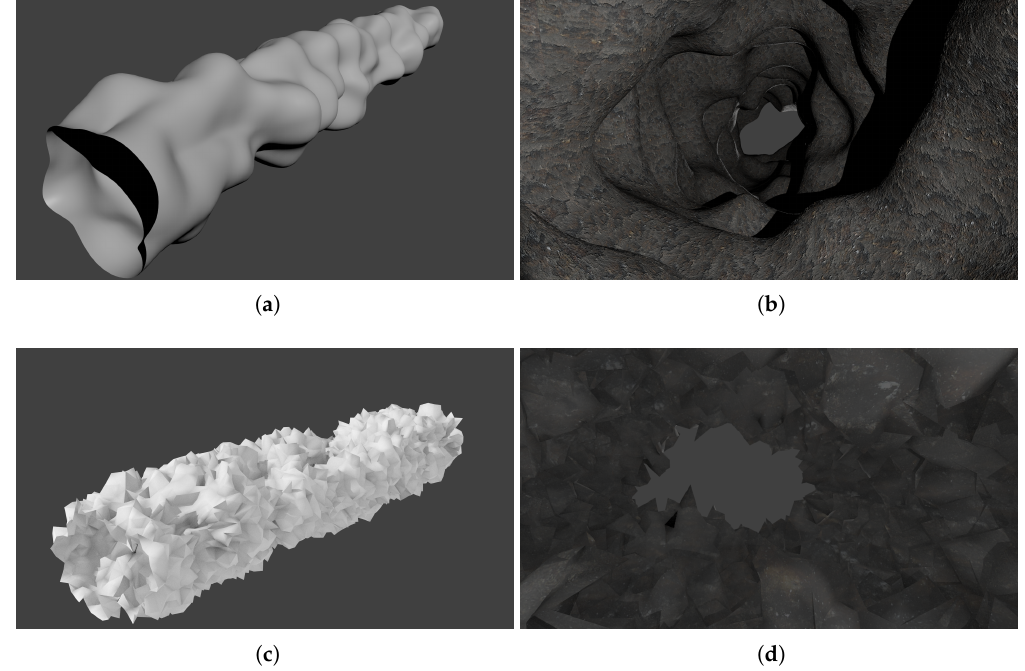
Figure 11. Models used in our simulations. Note that for generating sparse measurements, we used a scaled down version of the smooth karst model. ( a ) Outside view of the smooth karst model. ( b ) Inside view of the smooth karst model. ( c ) Outside view of the chaotic karst model. ( d ) Inside view of the chaotic karst